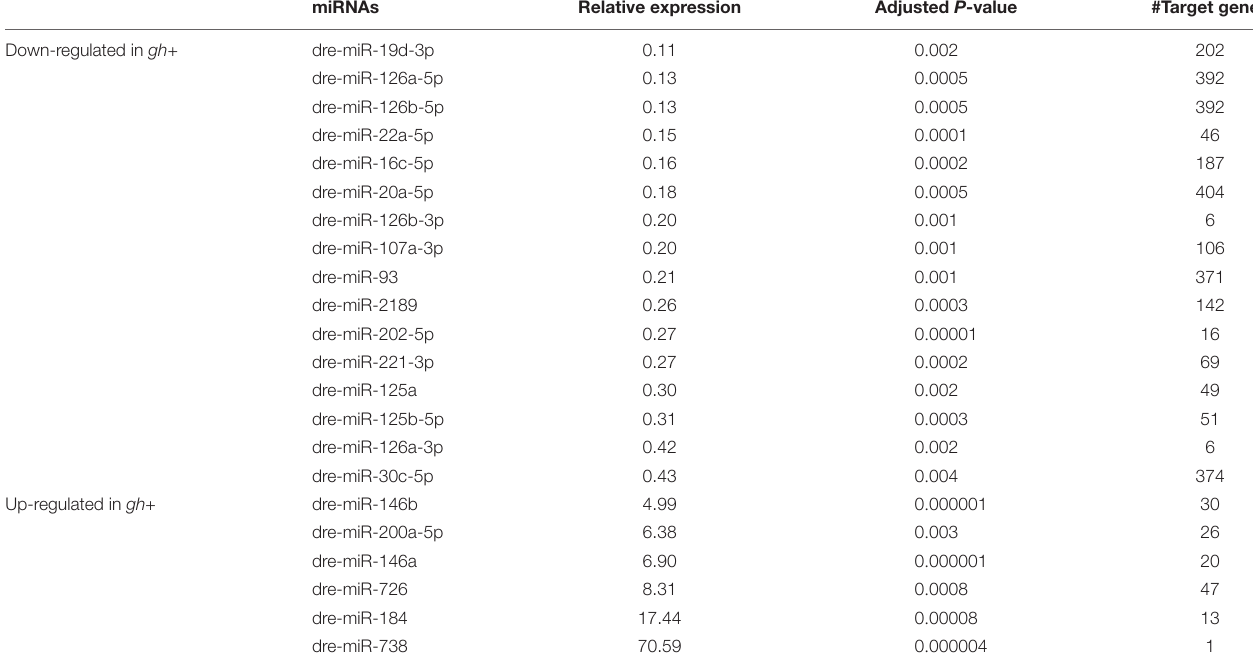
TABLE 2 | List of differentially expressed microRNAs (miRNAs) in sperm cells of gh -transgenic and non-transgenic zebrafish. miRNAs Relative expression Adjusted P -value #Target genes